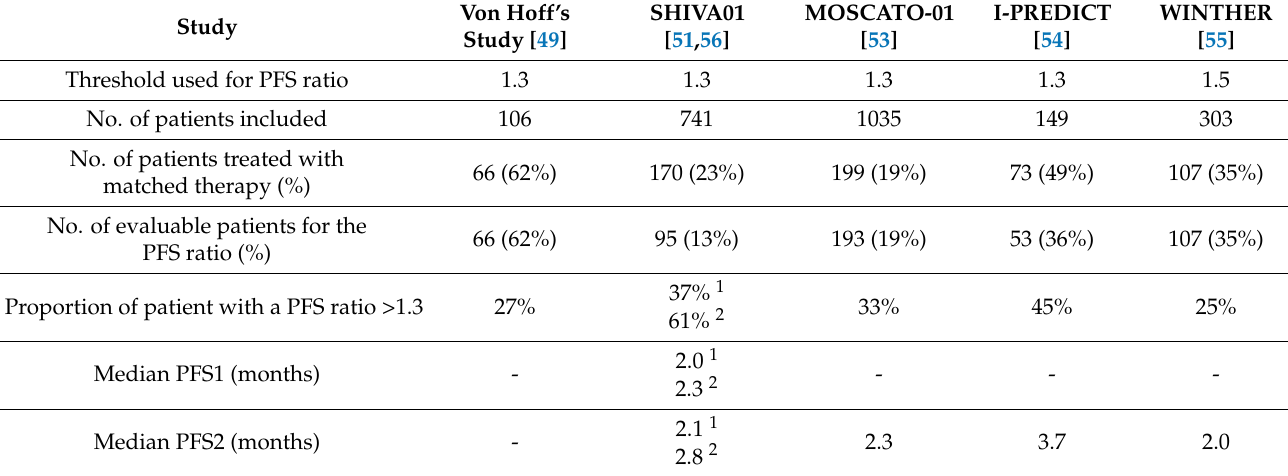
Table 2. Selected clinical trials using each patient as his/her own control to assess efficacy. Study